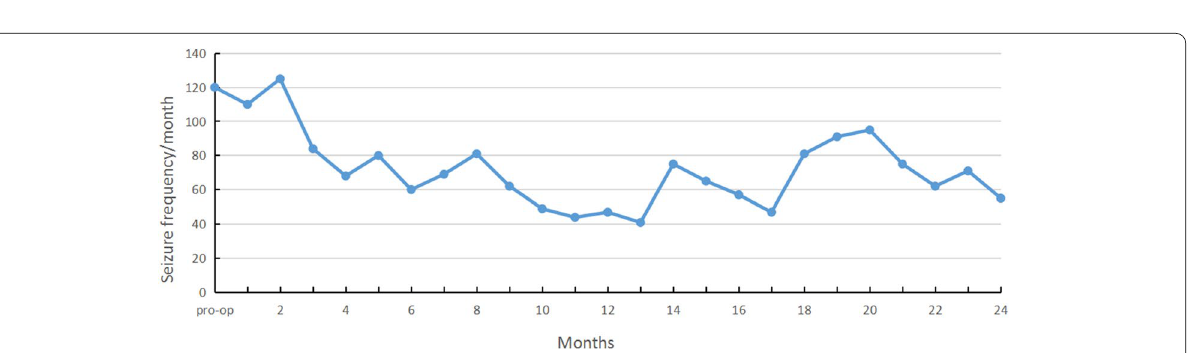
Fig. 2 Monthly seizure activities. After VNS, the patient’s seizure frequency was reduced by 50% at the last follow